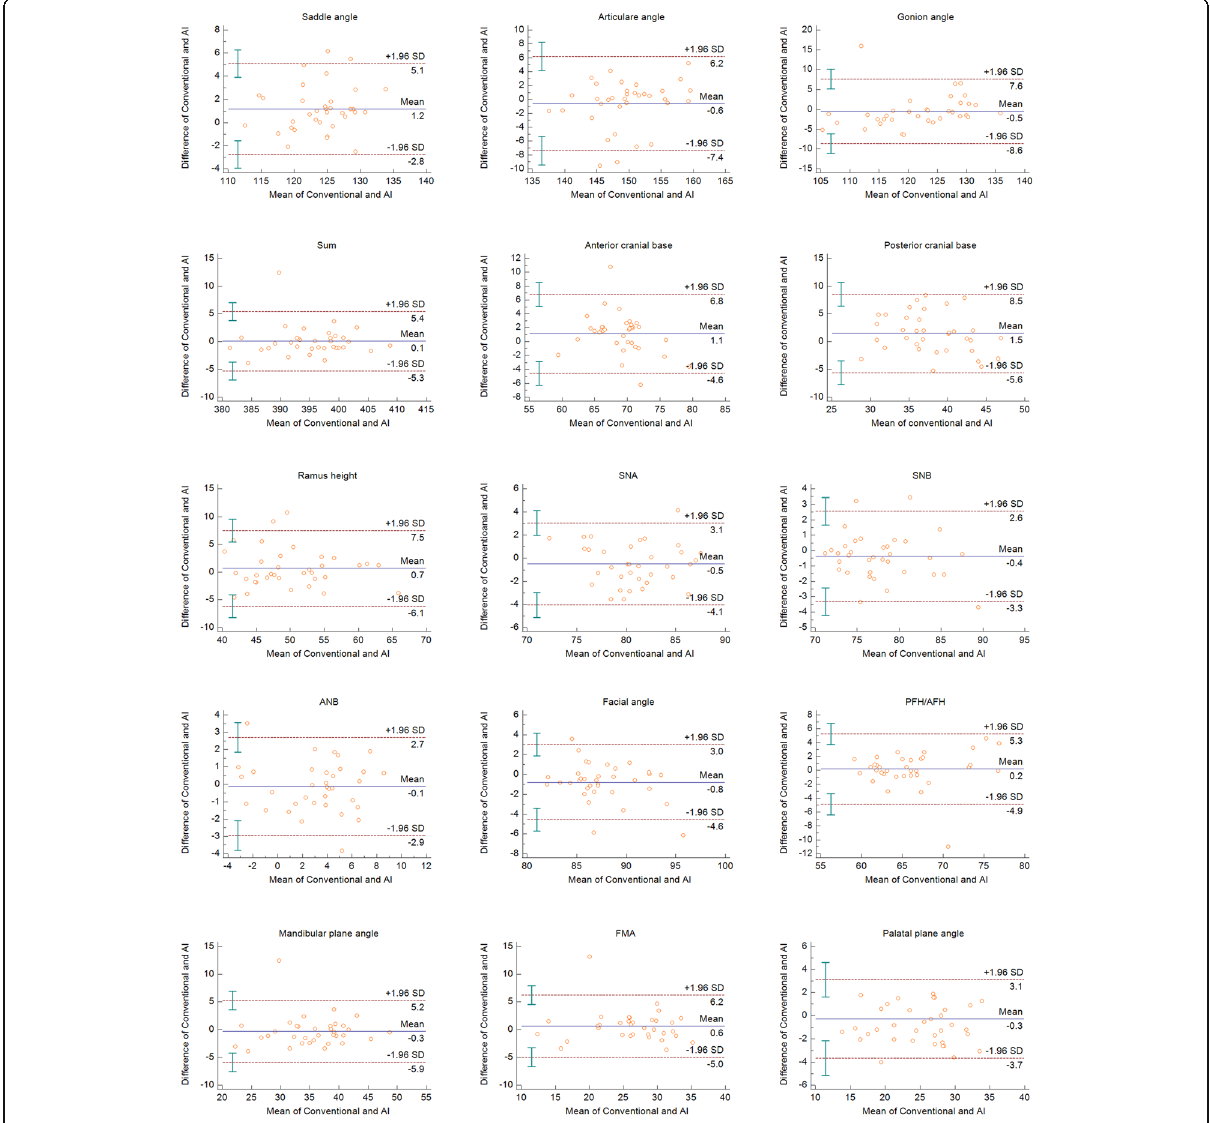
Fig. 2 Bland-Altman plots for the skeletal measurements in each conventional and AI methods. For each plot, the x -axis represents the mean of the compared measurements, and the y -axis represents the difference between the compared measurements. The blue line represents the bias, and the red-hashed lines represent the upper and lower limits of